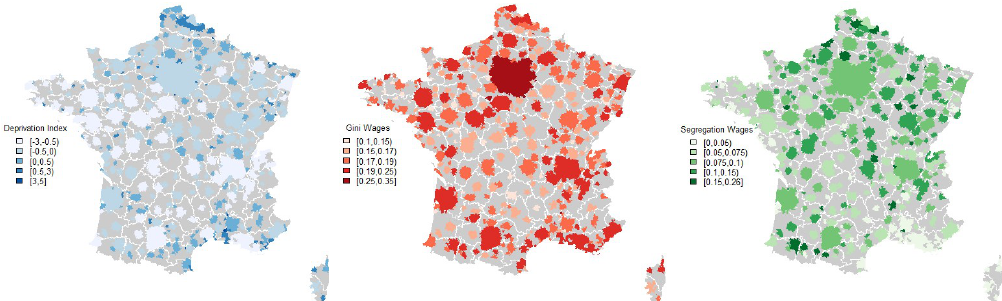
Figure 1. Maps of deprivation, inequality and segregation levels for metropolitan areas with more than 10,000 residents in